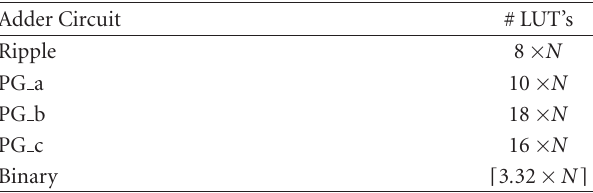
Table 2: Area (in LUTs) for di ff erent adder’s size in Virtex-4.